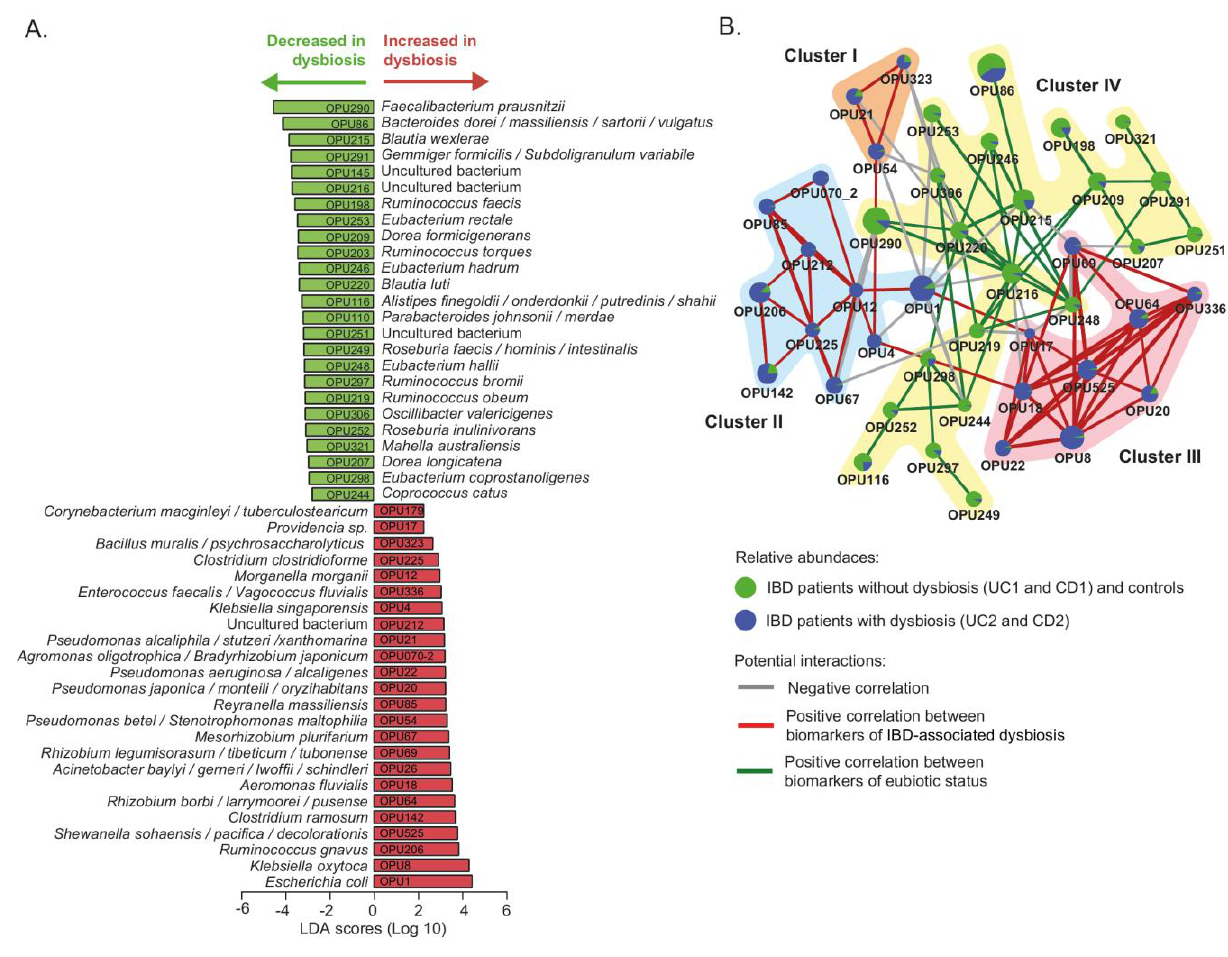
FIGURE 4: Differently abundant OPUs in dysbiotic IBD patients and their co-existence networks. (A) The LEfSe algorithm with a linear dis- criminant analysis (LDA) score >2 enabled the identification of OPUs that differed significantly in abundance between the dysbiotic patients (UC2 and CD2 groups) and eubiotic patients (UC1 and CD1) and non-IBD controls (B) Correlation networks of differently abundant OPUs. This analysis was performed using SparCC [57] (see methods). The nodes (pie charts) represent OPUs, with size reflecting the relative abundance in IBD patients and controls, as described in the legend. The links between nodes correspond to significant interactions (positive or negative correlations), with line width reflecting the strength of the correlation. Clusters (I to IV) of highly correlated OPUs are indicated. Unconnected nodes were